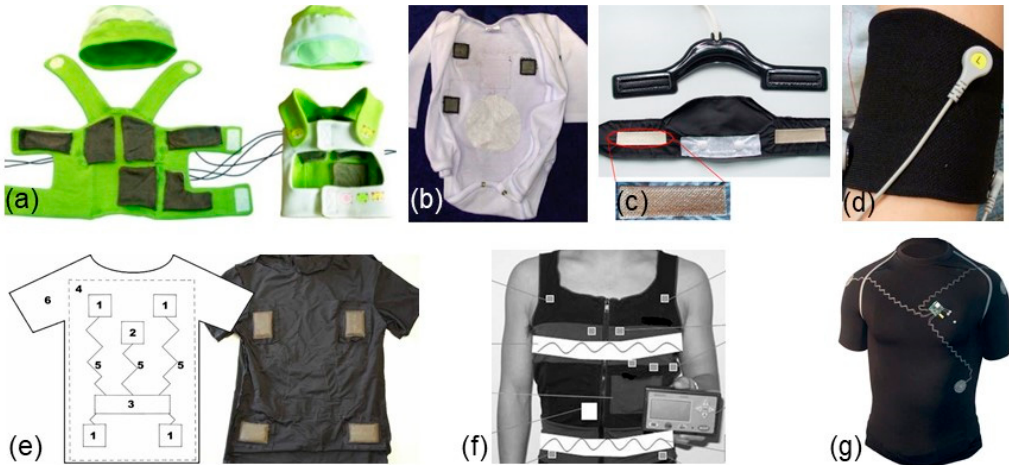
Figure 4. Wearable electrocardiography (ECG) systems: ( a ) jacket for baby [108]; ( b ) textile electrodes embedded into a baby suit [109]; ( c ) belt with embroidered electrodes [59]; ( d ) armband with embedded textile electrode [69]; ( e ) Bluetooth-enabled mobile ECG monitoring system integrated on a t-shirt [133]; ( f ) t-shirt embedded with textile electrodes and a local portable device [110]; ( g ) t-shirt with embroidered electrodes [134].